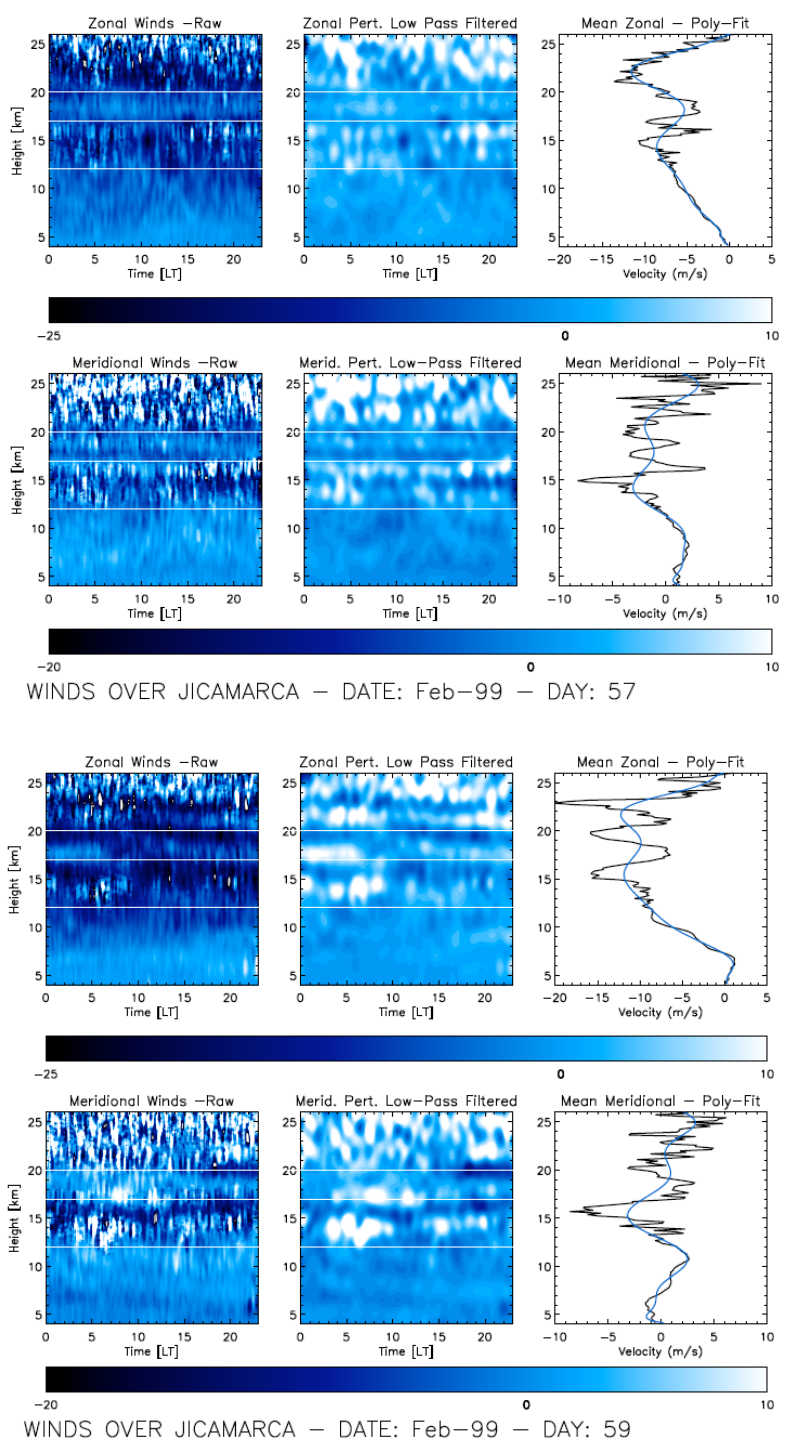
Fig. 2. Contour plots showing MST winds measured over Jicamarca on two days in February 1999. The left column shows the raw zonal (upper row/panel) and meridional (lower row/panel) wind measurements, the right column shows the daily mean winds with a polynomial fit, and the center column shows the low-pass filtered perturbations from the estimated daily mean vertical wind profile. Note that the color scale for the zonal winds is not the same as the color scale for the meridional winds. Horizontal white bars represent bounding heights of high SNR [see text].